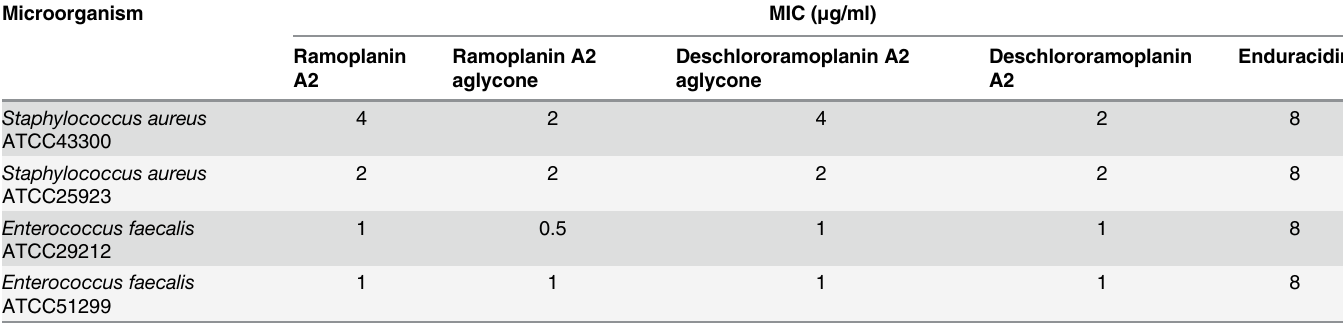
Table 2. Antibacterial activity of ramoplanin and purified its